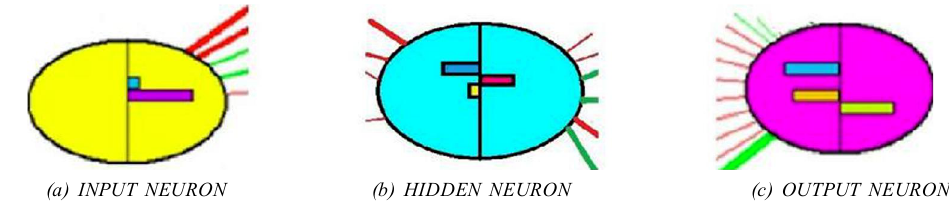
FIG. 8. INTERNAL PARAMETERS OF